Question: Sum up the contents of this chart in one sentence.
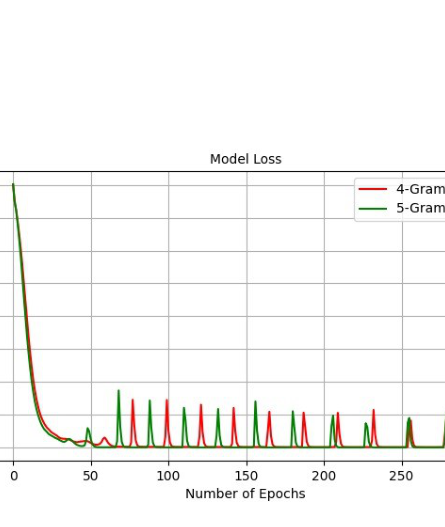
Answer: 4-Gram and 5-Gram model loss per epochs